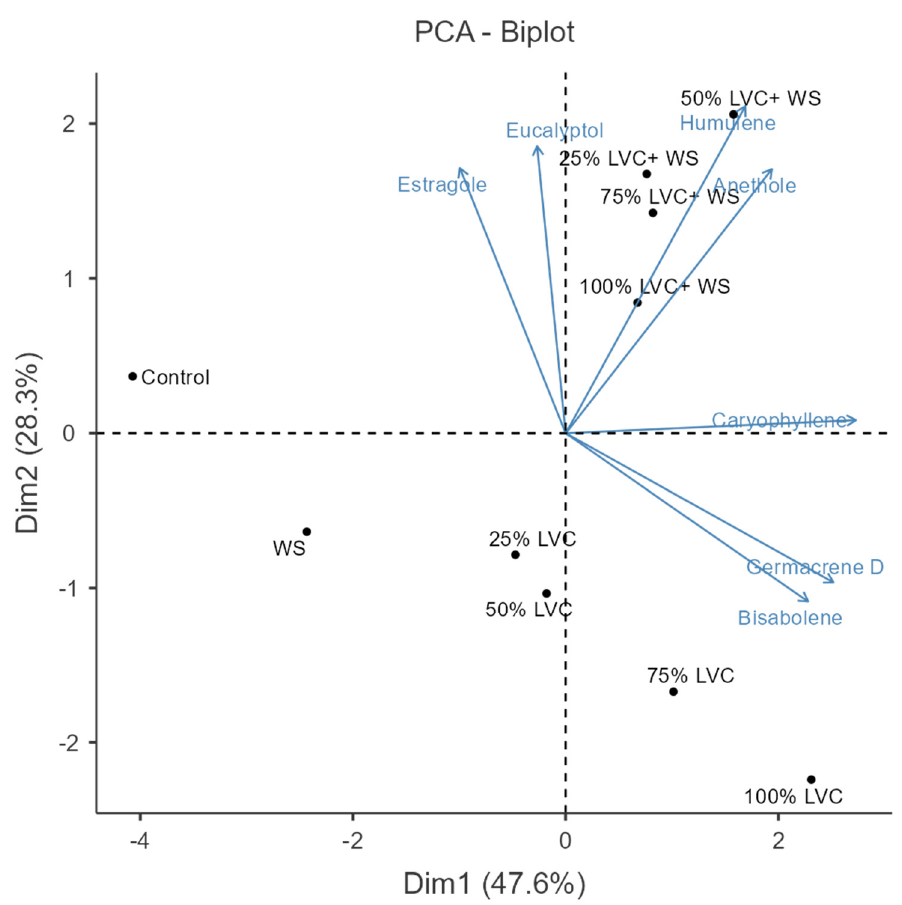
Figure 6. Correlation analysis of essential oil compounds corresponding to the treatments.